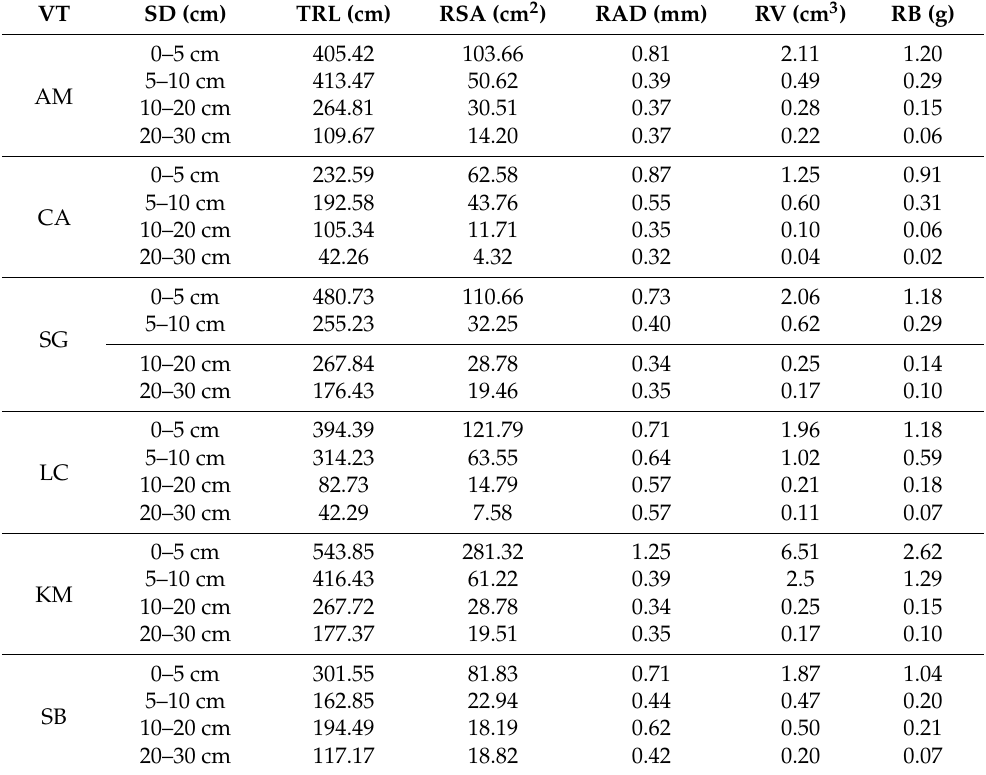
Table 3. Root characteristics of different communities.